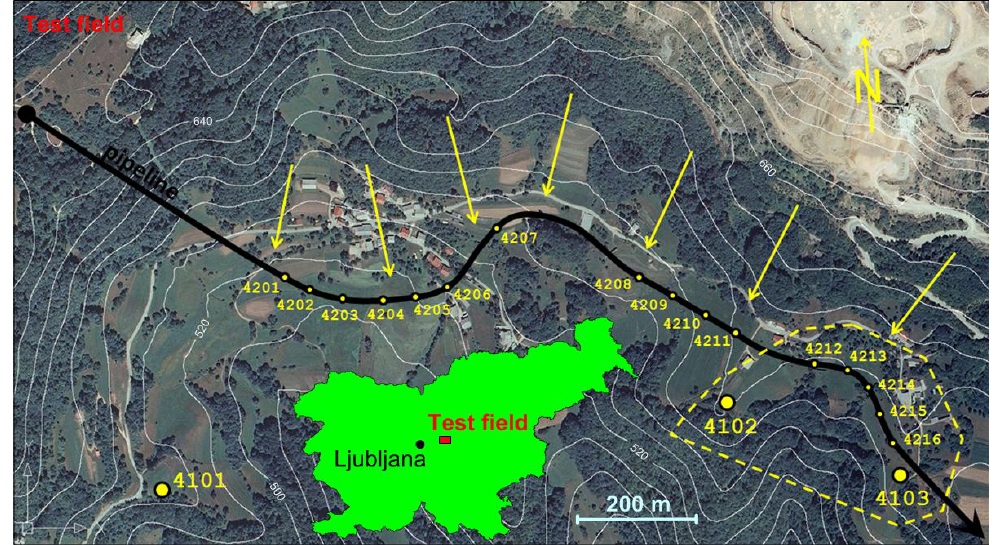
Figure 1. Orthophoto image of the test field (due to the size of the test field and the research nature of this research project, only the area, indicated by the dashed line, was